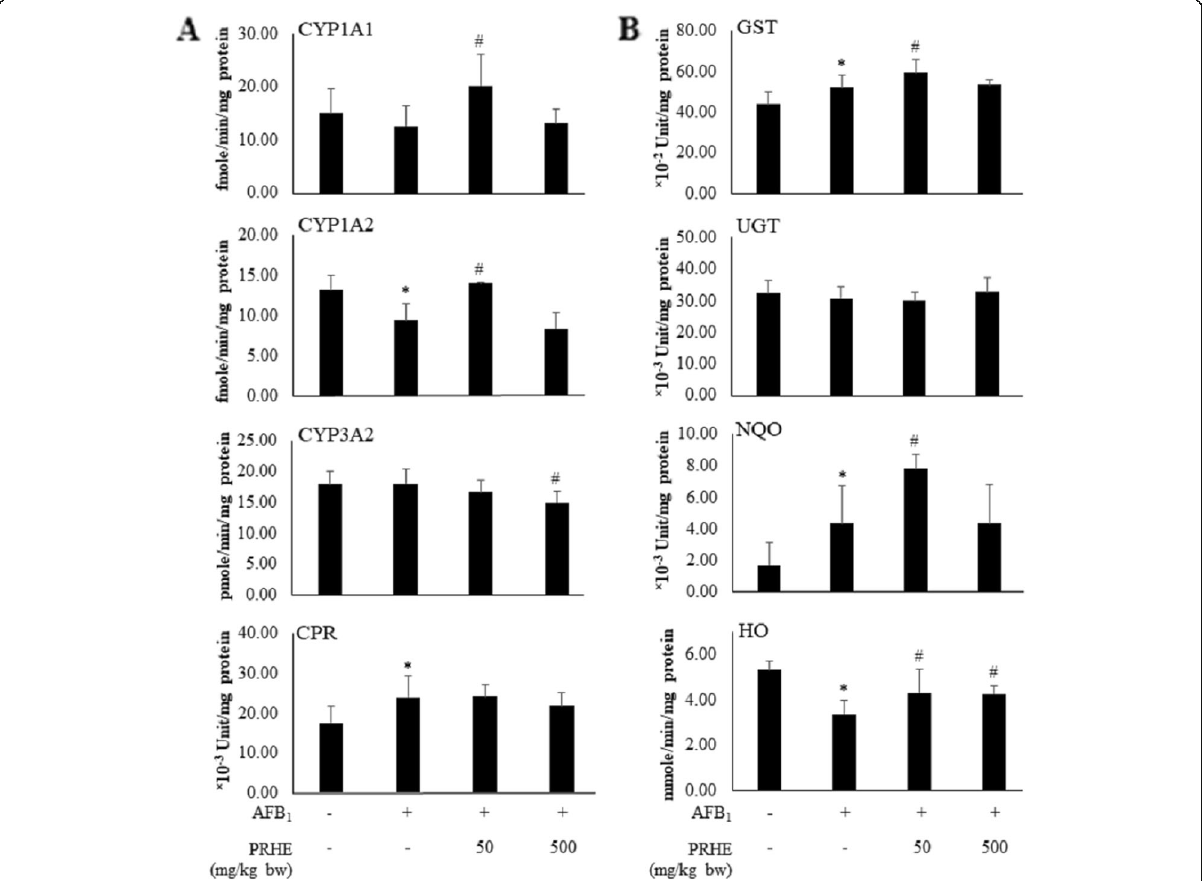
Fig. 4 Effect of purple rice husk extract on activities of xenobiotic metabolizing enzymes in the liver of AFB 1 -initiated rats. ( a ) phase I xenobiotic metabolizing enzymes, ( b ) phase II xenobiotic metabolizing enzymes. Values expressed as mean ± SD, n = 6. AFB 1 : aflatoxin B 1 ; PRHE: purple rice husk extract; CYP: cytochrome P450; CPR: cytochrome P450 reductase; GST: glutathione S -transferase; UGT: UDP-glucuronyltransferase; NQO: NAD(P)H quinone oxidoreductase; HO: heme oxygenase. * Significant difference from control group ( p < 0.05). # Significant difference from AFB 1 - treated group ( p <